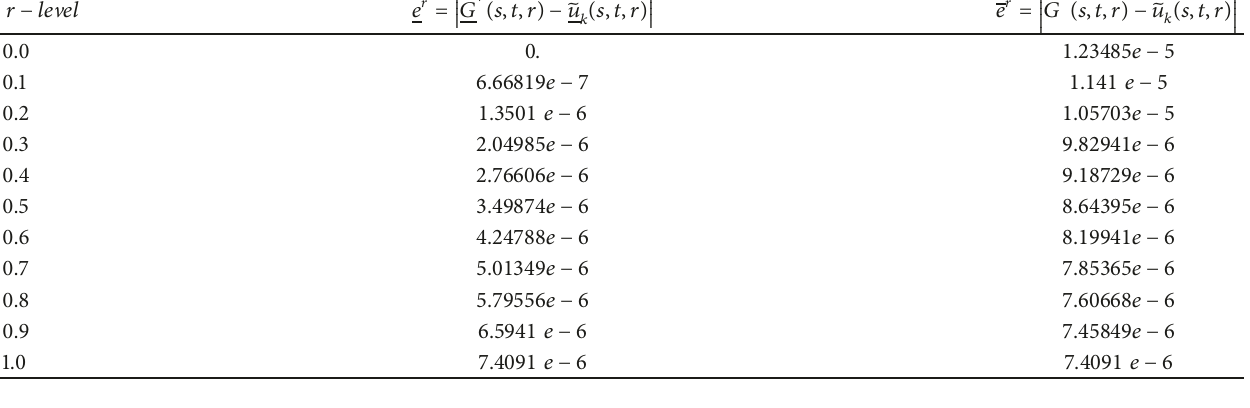
Table 1: The absolute errors on the level sets with 𝑛 = 2 , 𝑘 = 5 for Example 13 by using the proposed method (𝑠, 𝑡) = (0.5,0.5) . 𝑟 − 𝑙𝑒 V 𝑒𝑙 𝑒 𝑟 = 0.0